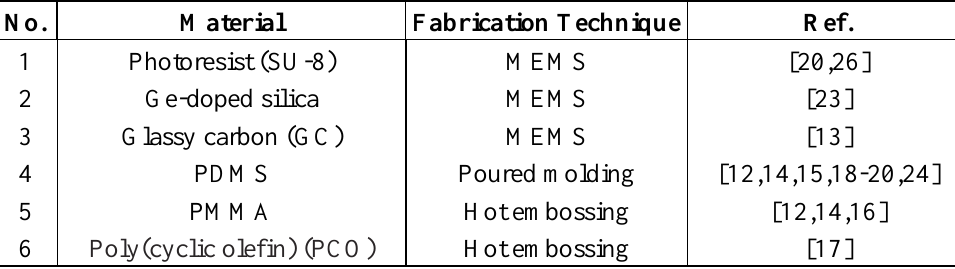
Table 2. Materials used in opto-microfluidic devices by different molding fabrication techniques. No. Material Fabrication Technique Ref. Photoresist